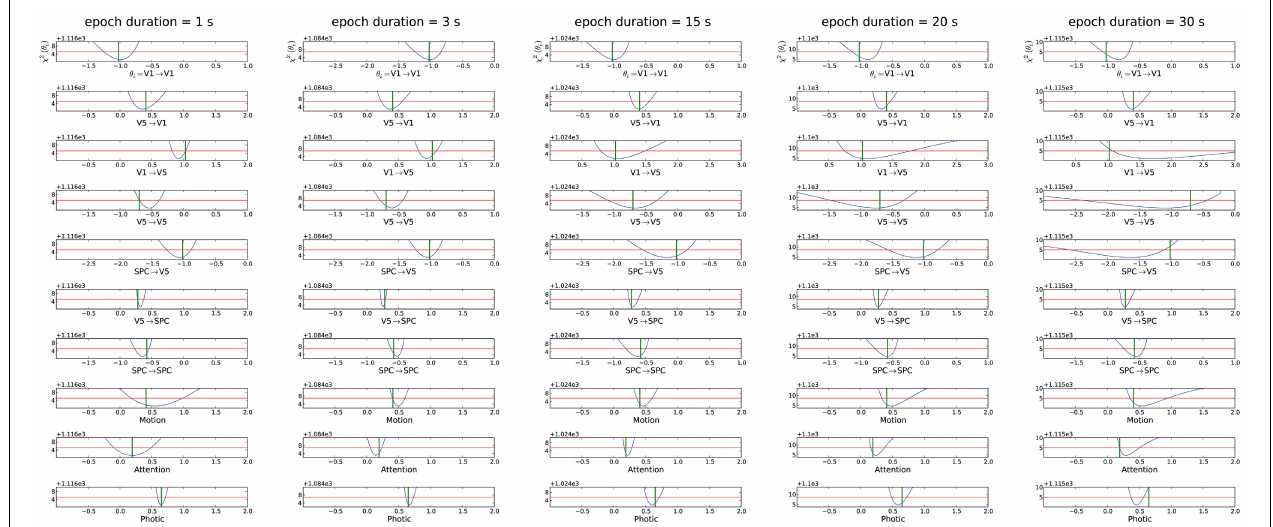
FIGURE 4 | Assessment of different epoch durations ranging from 1s, which is equivalent to stimulus durations of rapid event-related designs, up to a blocked design equivalent of 30s. The mCI were from left to right 0.32, 0.22, 0.36, 0.46, and 0.72. For explanation of the graphs see Figure 2 .